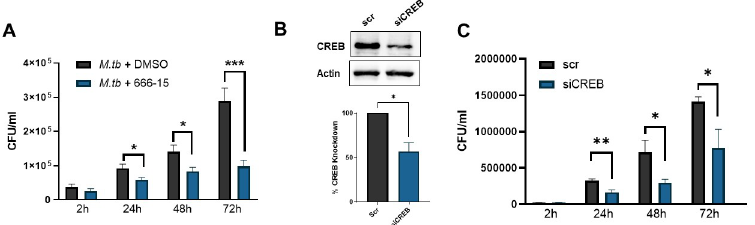
Fig 5. M . tb -induced CREB activation is important for bacterial growth in human macrophages. A) MDMs were pretreated for 60 min with CREB inhibitor 666–15 or DMSO, then infected with M . tb H 37 Rv MOI 2 and CFUs were determined at the indicated time points. Data are cumulative ± SEM of n = 6 donors. Unpaired t test. B) MDMs were transfected with CREB targeting siRNA or scrambled control for 72h prior to infection with M . tb H 37 R v MOI 2. A representative WB is shown and graphed data are cumulative ± SEM of n = 2 donors. C) CFUs were determined at the indicated time points. Data are representative ± SD of n = 2 donors. Unpaired t test; * p < 0.05, ** p < 0.01, *** p <